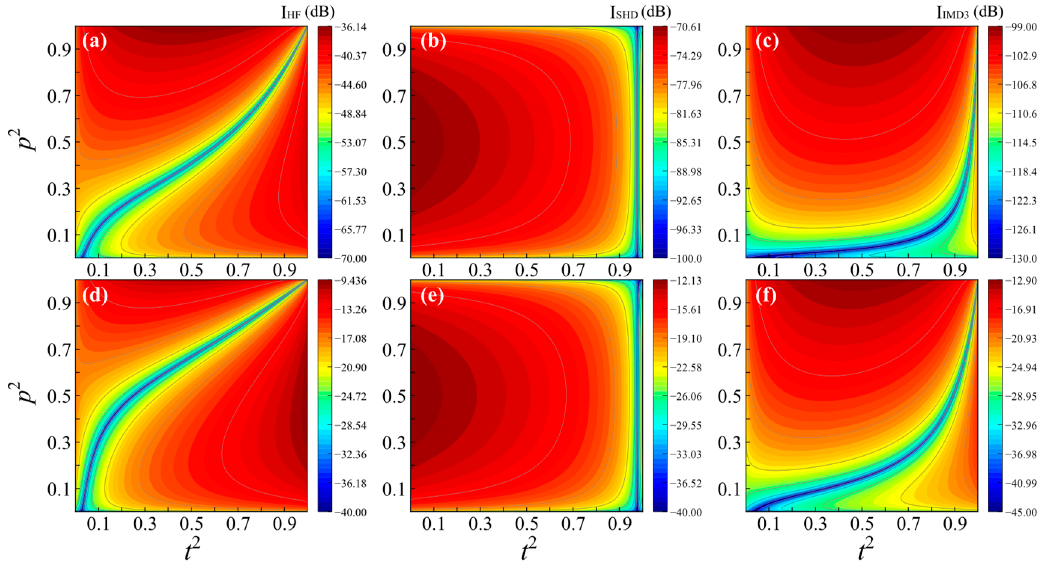
Figure 8. Contour map of the photocurrent as a function of t 2 and p 2 at ( a – c ) x 0 = 0.001 and ( d – f ) x 0 =